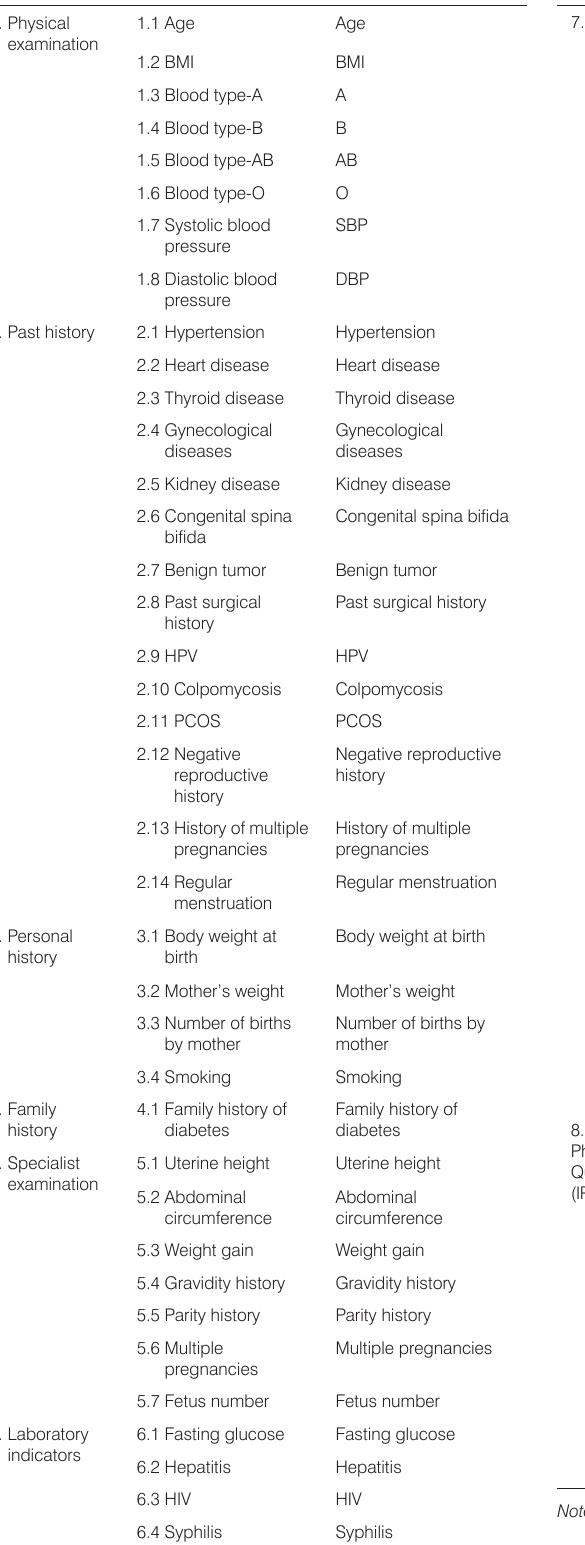
Table 1. Definition of input data variables for model training. ( Continued